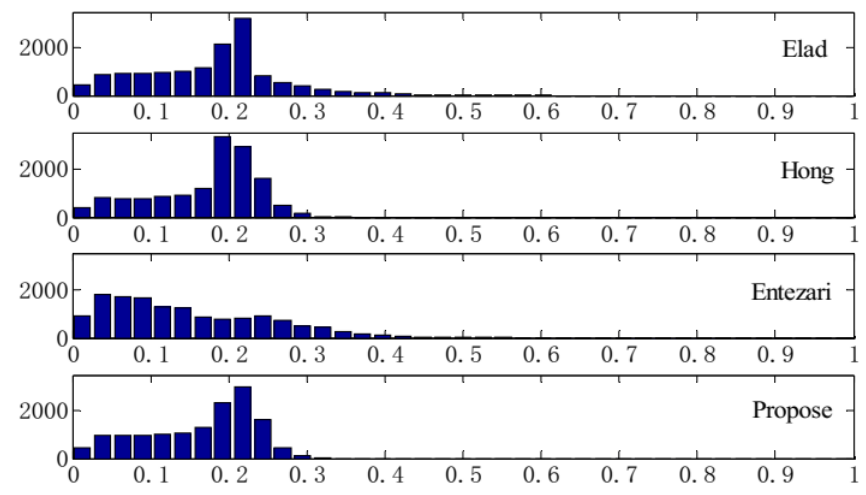
(cid:0) Φ Ψ for M = 28. Ψ (cid:1) (cid:48) Φ opt opt